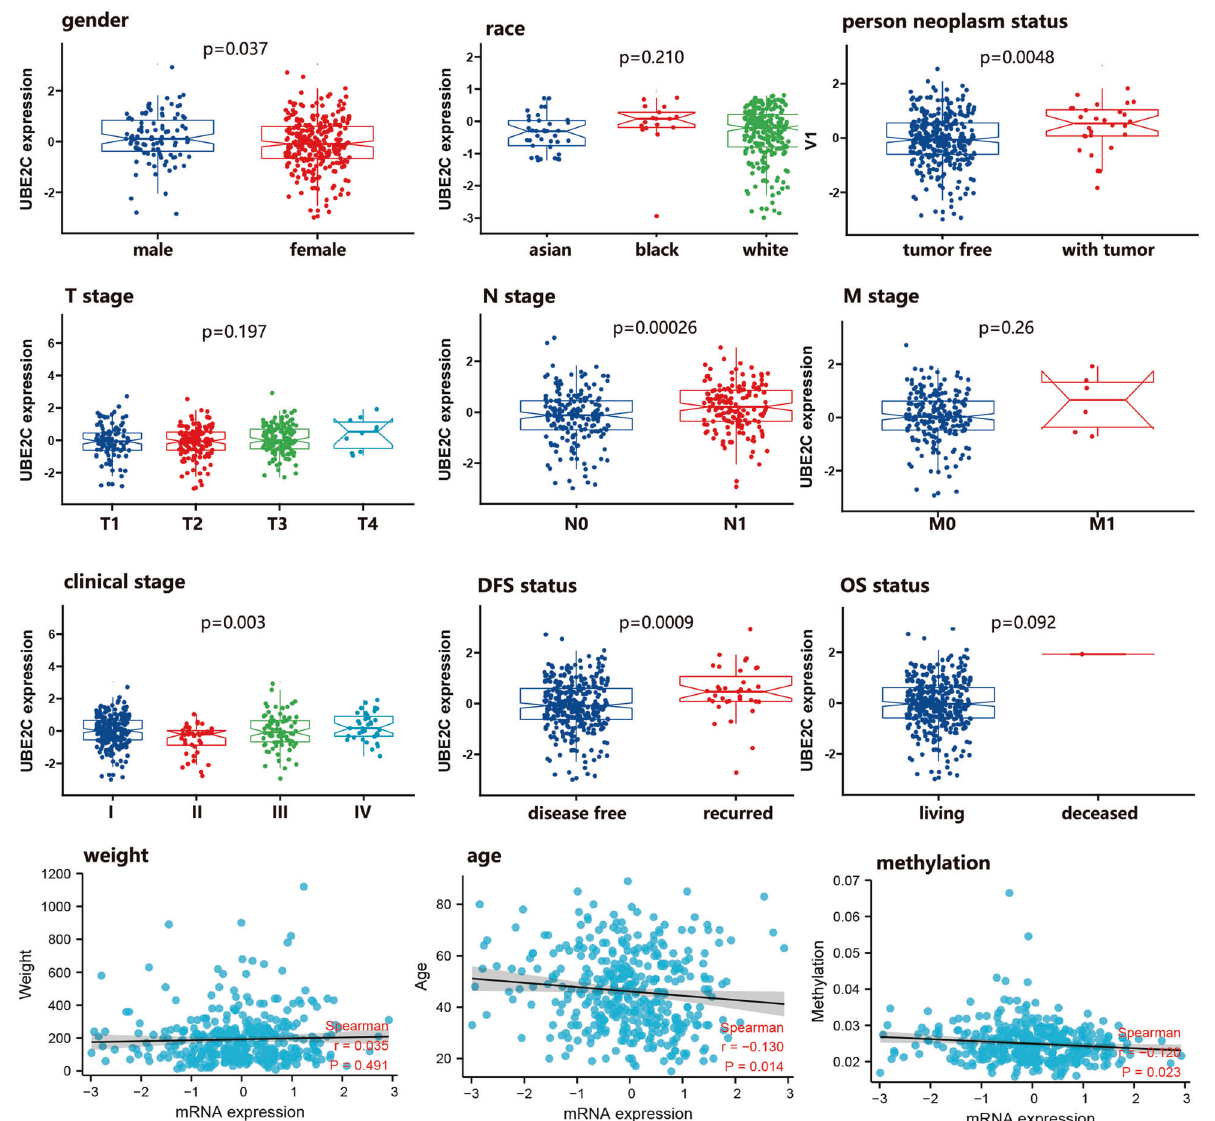
Fig. 3 The correlation analysis between UBE2C mRNA expression and clinical characteristics of THCA patients. UBE2C ubiquitin- conjugating enzyme E2 C, THCA thyroid carcinoma, DFS disease-free survival, OS overall survival, T primary tumor, N regional lymph nodes, M distant